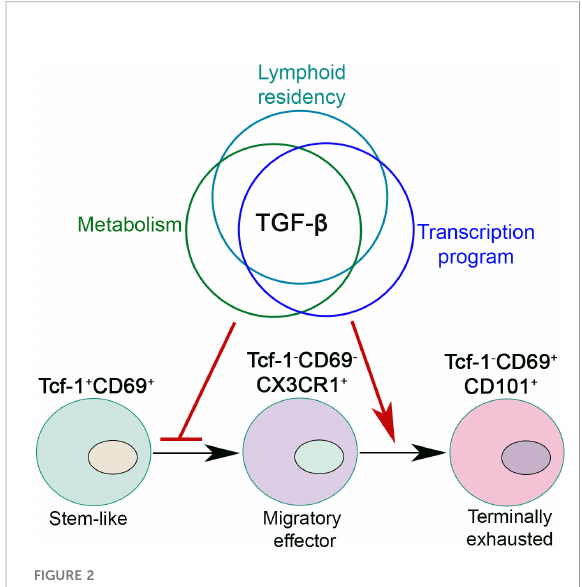
FIGURE 2 TGF- b controls exhausted CD8 + T cell differentiation during chronic viral infection. TGF- b integrates lymphoid residency, metabolic program and transcriptional control to inhibit the differentiation of migratory effectors and promote CD8 + T cell terminal exhaustion. In this fi gure, we present a lineal differentiation model for exhausted CD8 + T cells. To be noted, elegant evidence does exist to support a bifurcation model of exhausted T cell differentiation